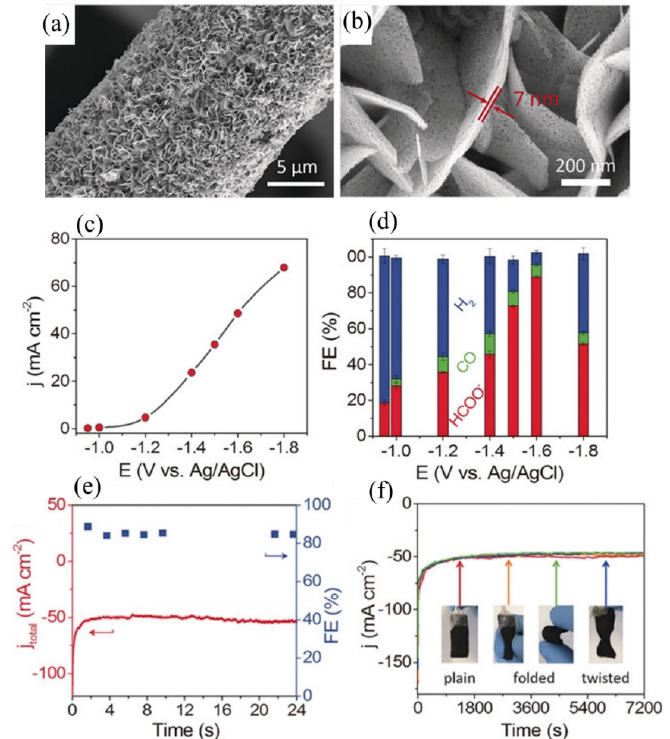
Figure 8. ( a , b ) The scanning electron microscope (SEM) images of porous SnO 2 nanosheets on carbon cloth (SnO 2 /CC). ( c ) Current density of the SnO 2 /CC electrode in CO 2 -saturated 0.5 M NaHCO 3 solution at different applied potentials. ( d ) Corresponding FE for formate, CO and H 2 . ( e ) i–t curve and FE for formate of SnO 2 /CC electrode in CO 2 -saturated 0.5 M NaHCO 3 solution at an applied potential of − 1.6 V for 24 h. ( f ) i–t curves of the SnO 2 /CC electrode at − 1.6 V after folding or twisting 10 times. Reprinted from [95], Copyright (2017), with permission from Wiley.